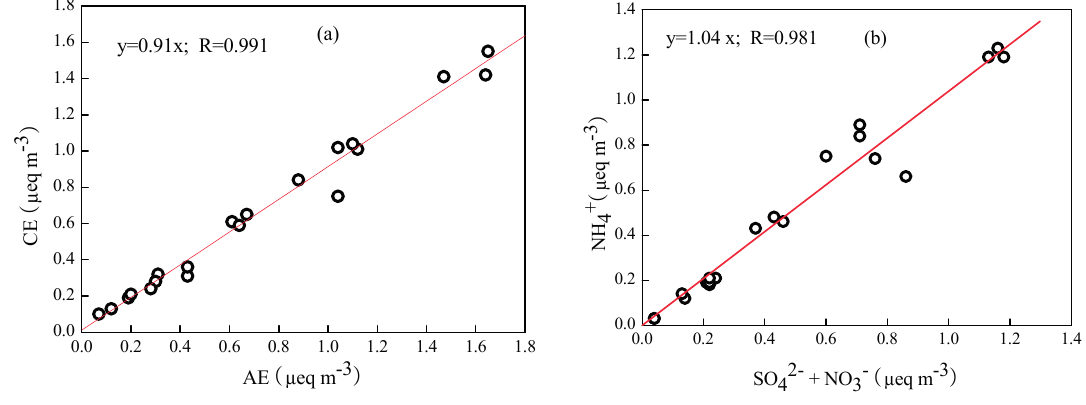
Figure 3. Relationships of equivalent concentrations of cations versus anions ( a ) and [NH 4+ ] versus [SO 42 − + NO 3 − ] ( b ).